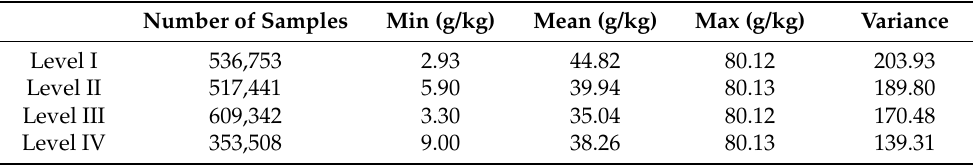
Table 5. Changes in SOM under different irrigation guarantee